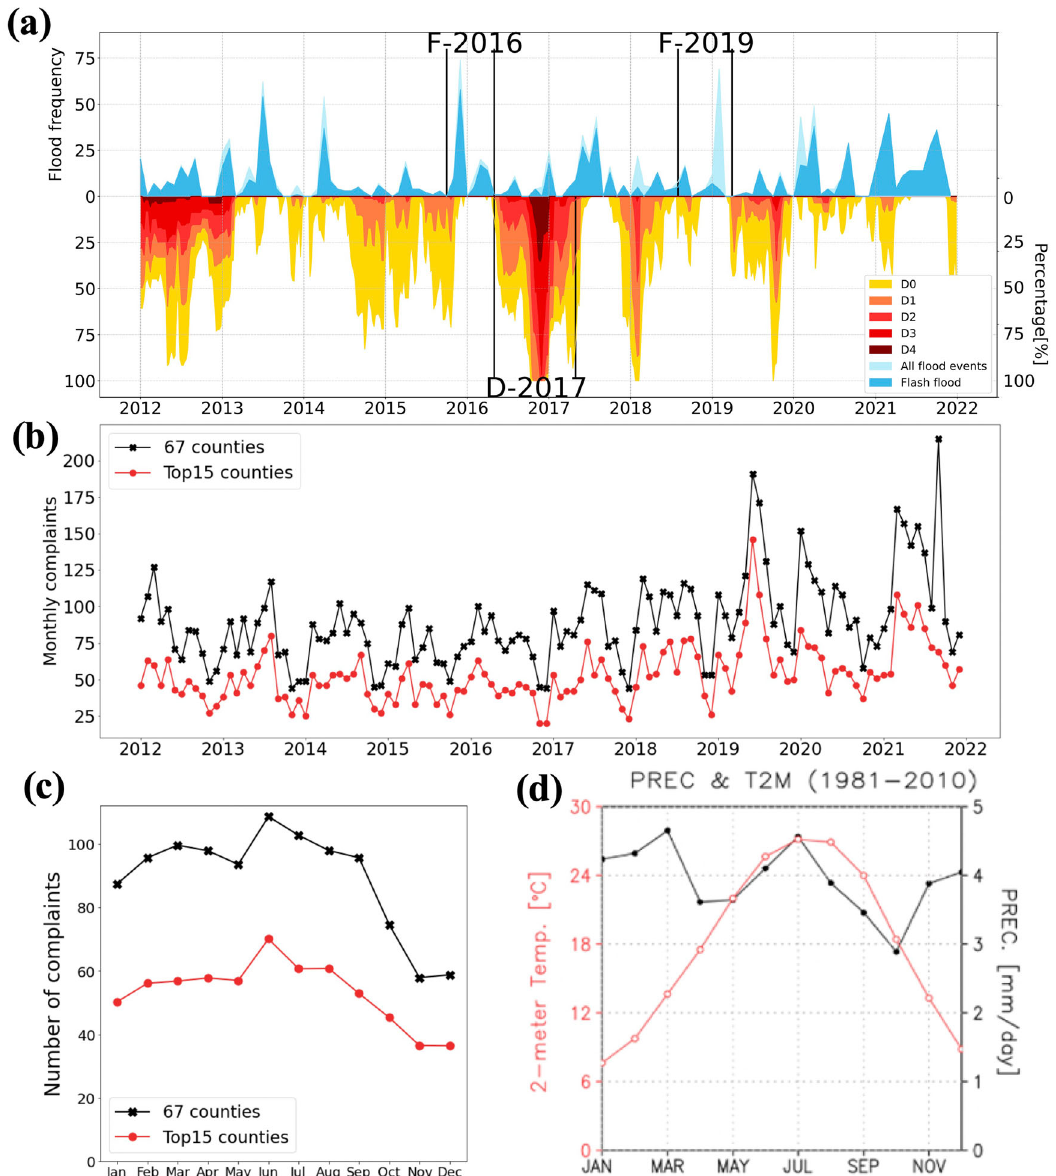
Fig. 1 Occurrences of droughts and fl oods correlated with the trends and seasonality of water pollution complaints in Alabama. a D0, D1, D2, D3, and D4 depict the area fractions under abnormal dry, moderate drought, severe drought, extreme drought, and exceptional drought conditions, respectively. The blue color represents for the numbers of fl ood and fl ash fl ood events for 2012 – 2021. The black lines in depict the drought (D-2017) and two fl ood periods (F-2016, and F-2019). b Total number of monthly water pollution complaints from top 15 counties (red line with circles), and the entire state (black line with crosses). c Long-term averages for the numbers of complaints per month from the top 15 counties (red line with circles), and the entire state (red line with crosses) for 2012 – 2021. d Monthly average temperature (°C) (red line with empty circles) and precipitation (mm) (black line with solid